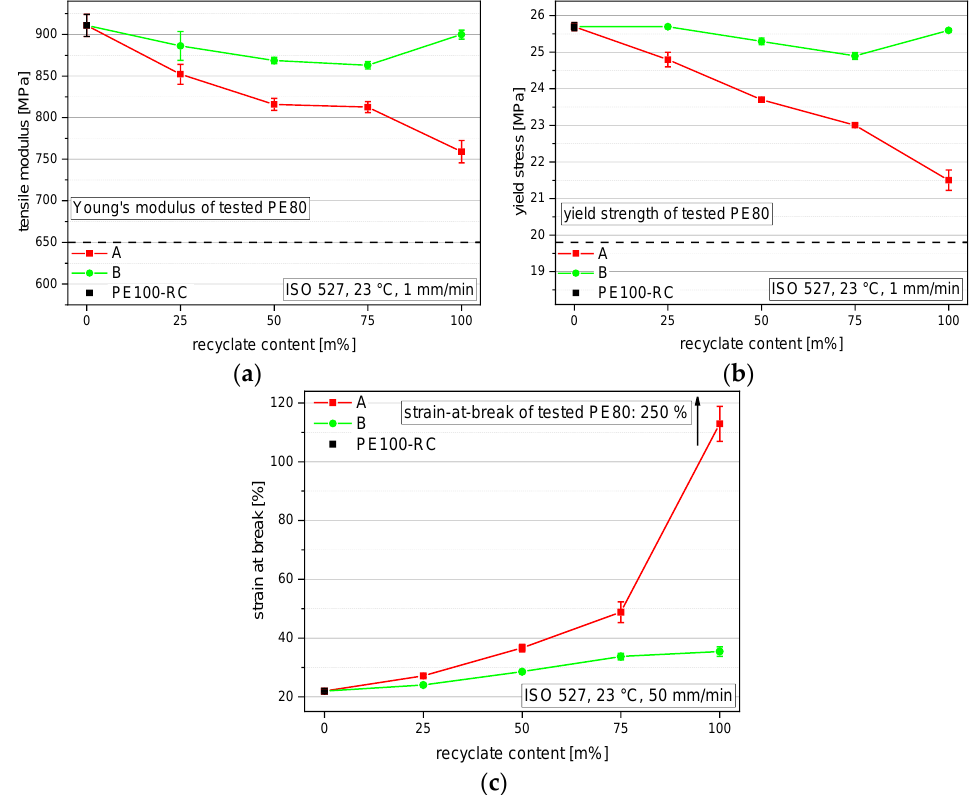
Figure 5. Graphical illustration of tensile modulus ( a ), yield stress ( b ), and strain at break values ( c ) of the virgin material PE100-RC (as 0 m% recyclate content data point for both compounding series), both recyclates (at 100 m% recyclate content), and the compounds containing 25 m%, 50 m%, and 75 m% rPE-A and rPE-B, respectively. The vertical bars show the sample standard deviation. Comparable trends can be found with the yield stress values, shown in Figure 5b. The strain at break values, as seen in Figure 5c, show trends similar to MFR.